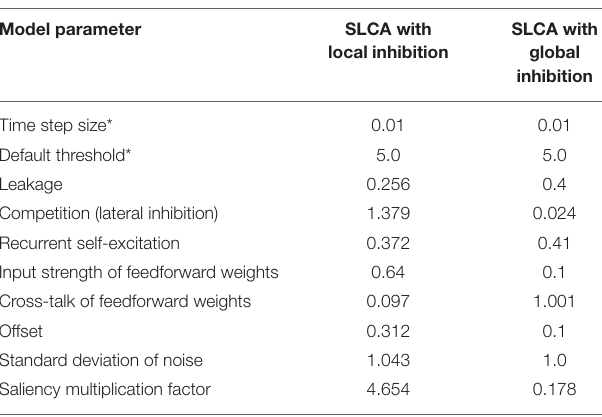
TABLE 2 | Best parameters found via